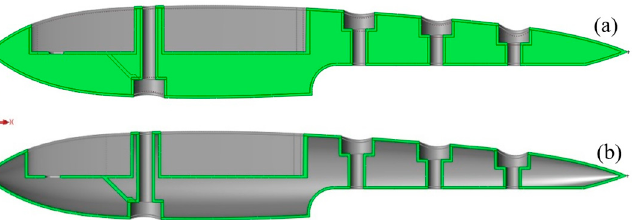
Figure 3. ( a ) Bulb 3D model partitioning, longitudinal section view; the main green internal portion is the “core” while its contour (shown in green) is part of the “case”, ( b ) case sectioned view, uniform thickness of 1 mm . The overall longitudinal length of the component is 290 mm .